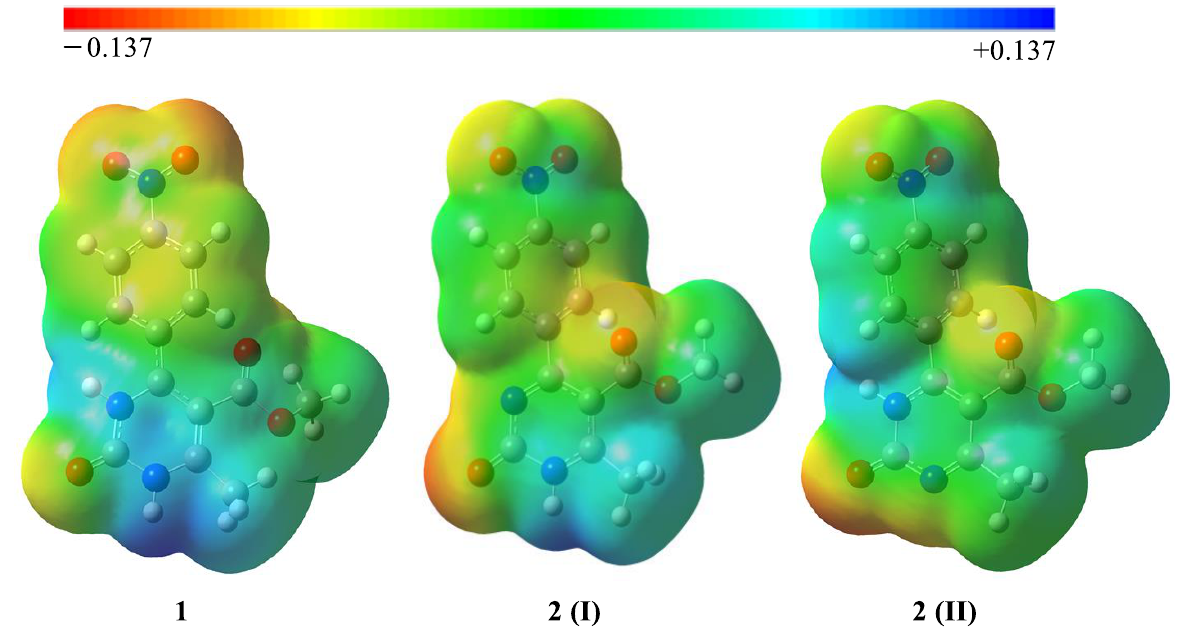
Figure 10. Molecular electrostatic potential maps calculated on the studied compounds.